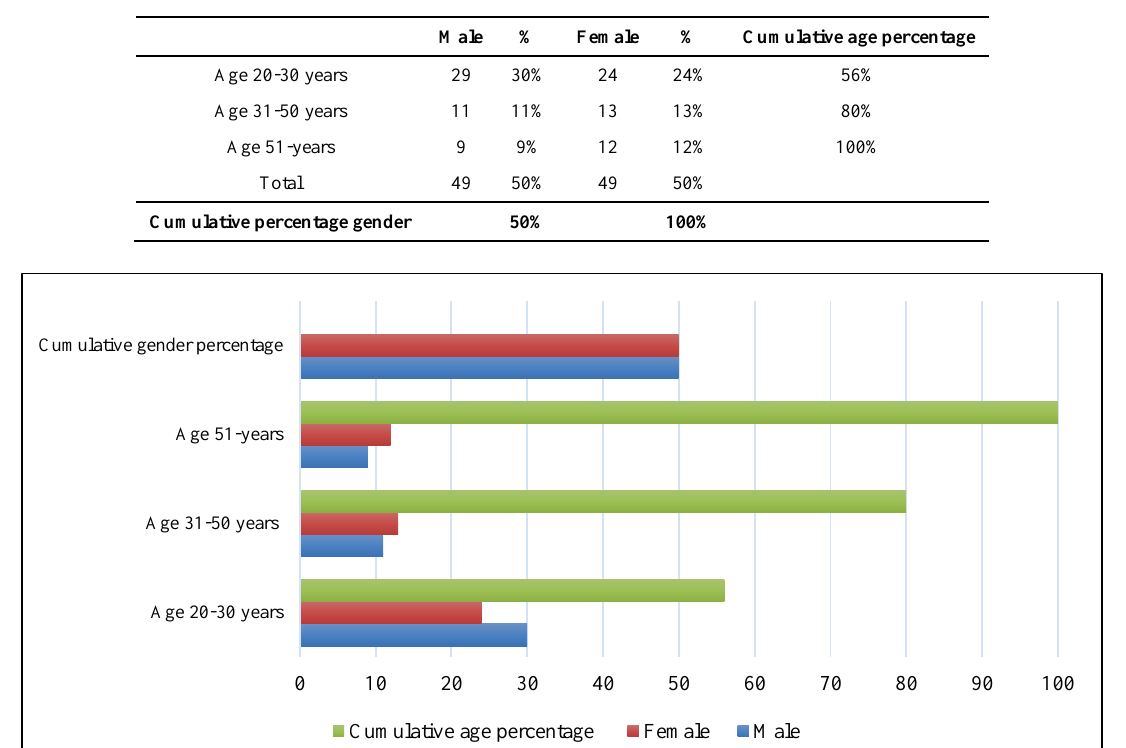
Figure 1. This graph presents data on the gender of patients included in the study: the first group and the second group This table presents the male-female demographic data, according to the age division for the first group and the second group. Table 2. Gender-age, first group and second group patients